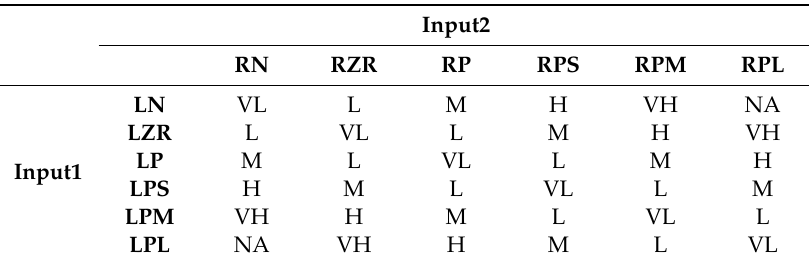
Table 1. Fuzzy rules set for the swing phase.